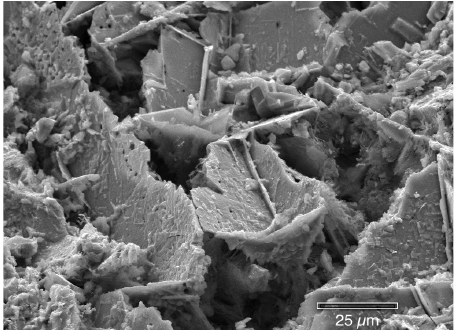
Figure 14. The copper crystallographic surfaces inside the pit (HMDS